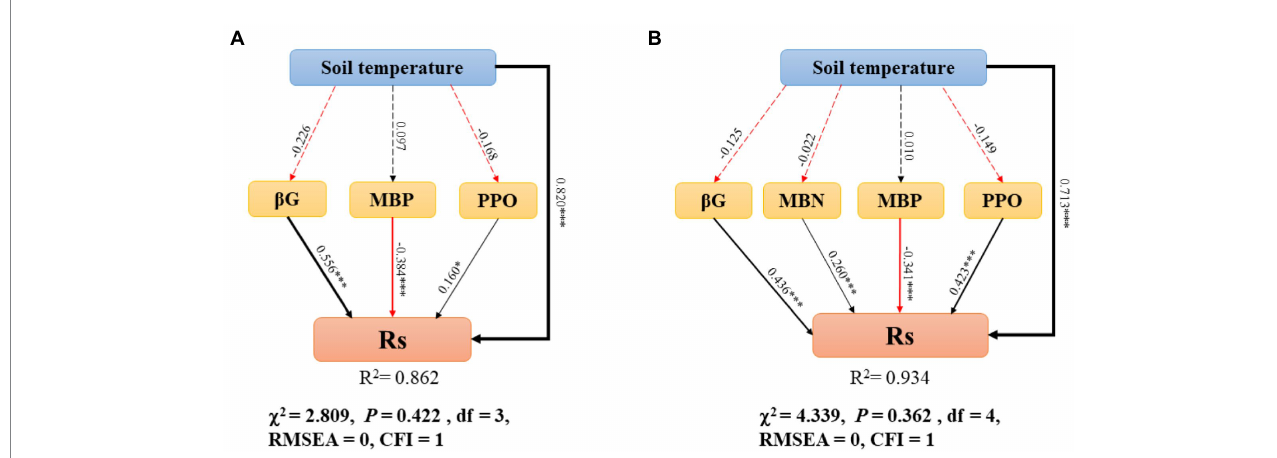
FIGURE 6 Structural equation model describes the relationship between variables and R S in the topsoil (A) and whole soil (B) . R S , soil respiration; MBN, microbial biomass nitrogen; MBP, microbial biomass phosphorus; PPO, polyphenol oxidase; β G, β -1,4-glucosidase; soil temperature (T S) . Arrows represent the assumed direction of causation. The width of arrow is proportional to the path coefficient. The red and black solid lines represent negative and positive pathways, respectively. Insignificant pathways are indicated by grey dashed lines. The importance of the variables is reflected by standardized path coefficients. R 2 reflects the proportion of variance explained for all variables in the model. The significance levels are as follows: * p < 0.05, ** p < 0.01, and *** p <